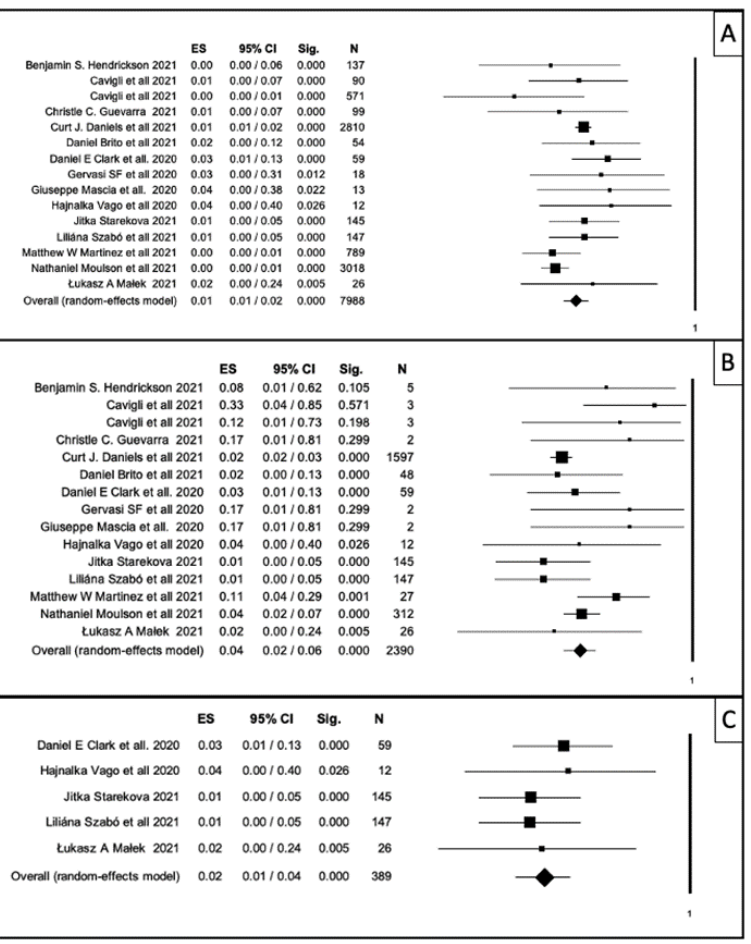
Figure 2. Forest plot: horizontal axis represents 95% confidence interval; rhombuses and squares represent the weight of the study in relation to the total. ( A ) Forest plot showing myocarditis event rate in the total sample of athletes ( n = 7988) who recovered from COVID-19 infection. ( B ) Forest plot showing myocarditis event rate only in the subgroup of athletes ( n = 2390) who were studied with CMR. ( C ) Forest plot showing myocarditis rate in studies in which all athletes who recovered from COVID-19 were studied with CMR. This subgroup included 389 athletes.